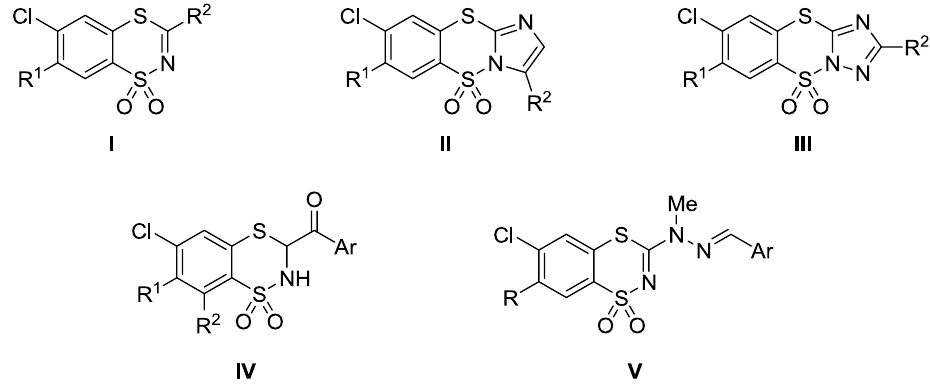
Figure 1. Chemical structures of biological active 1,1-dioxo-1,4,2-benzodithiazines I – IV [1–15], and V